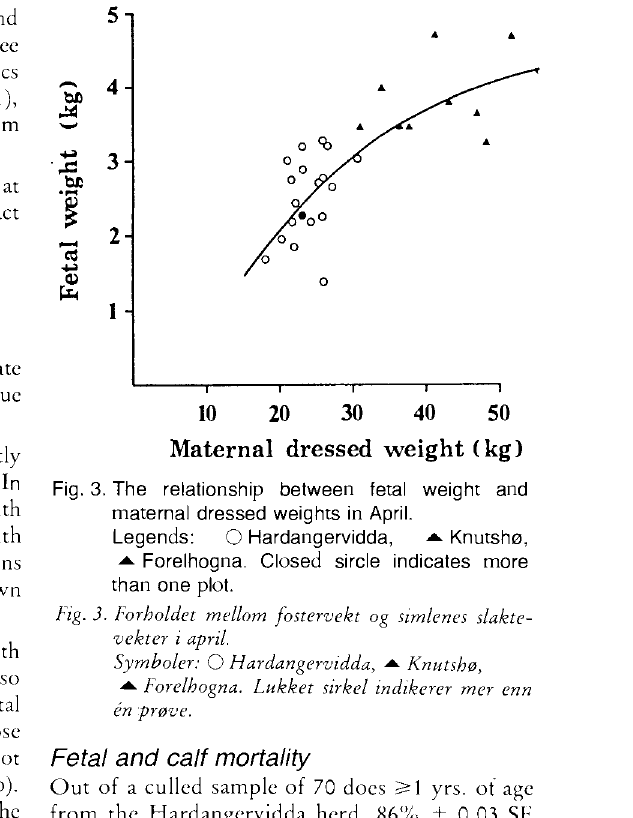
Table 1. Maternal dressed weights (kg).